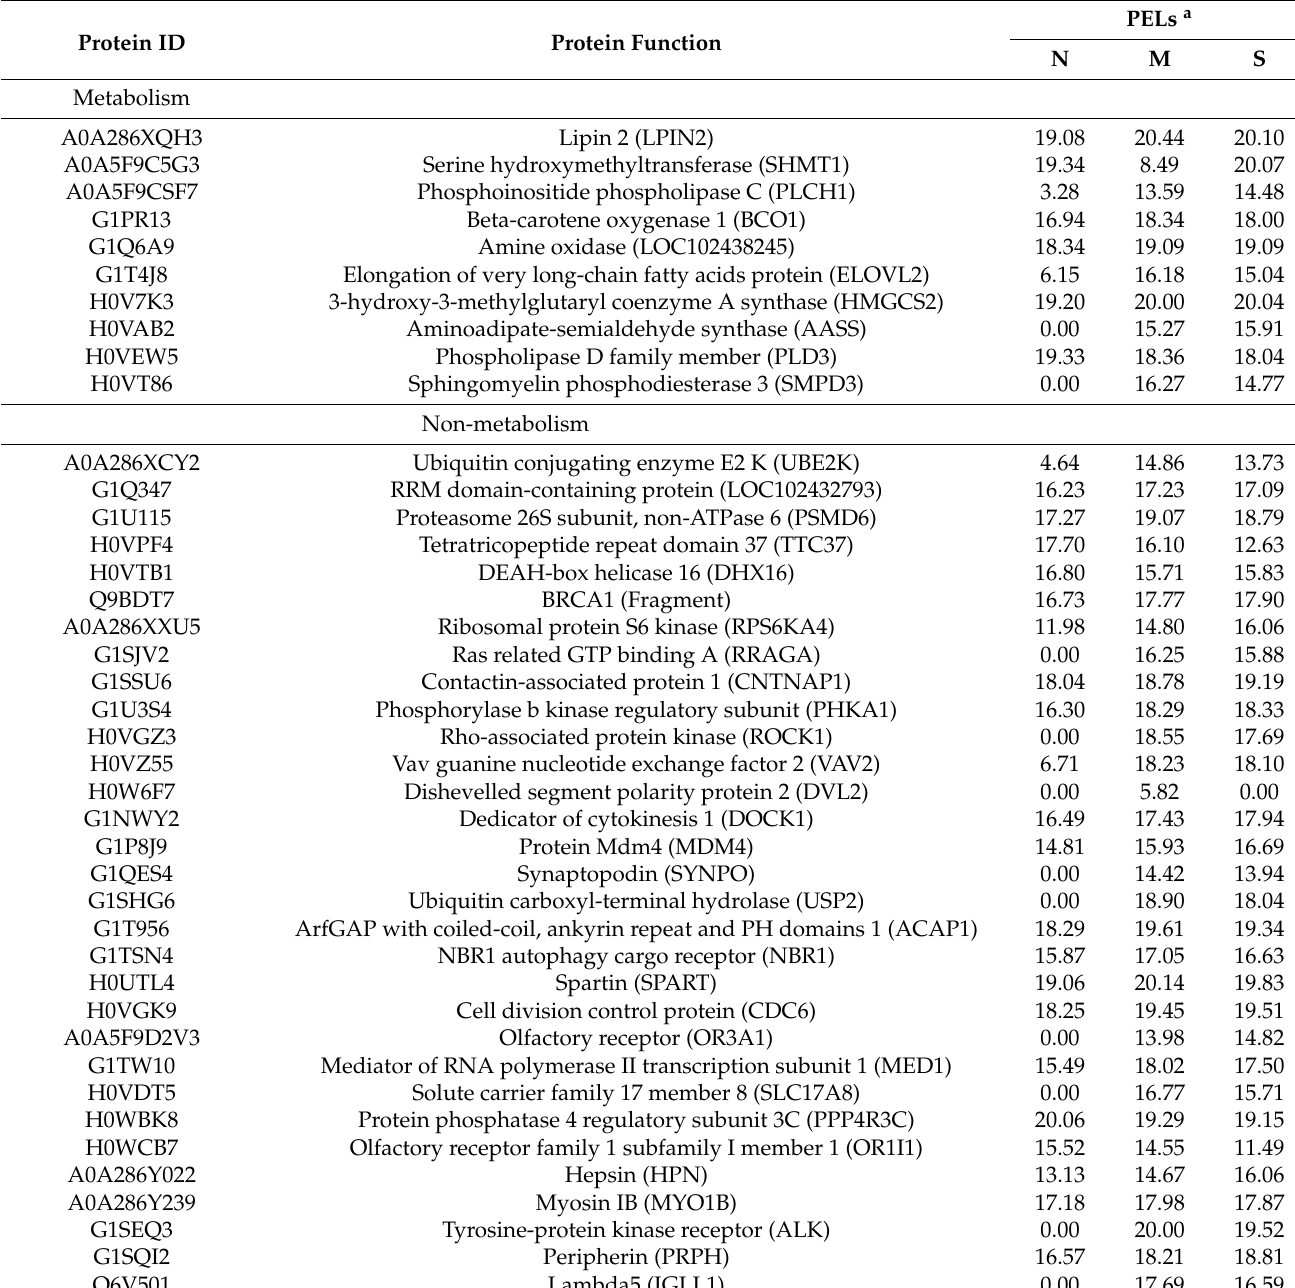
Table 3. List of 41 significant proteins and associated functions across EMN